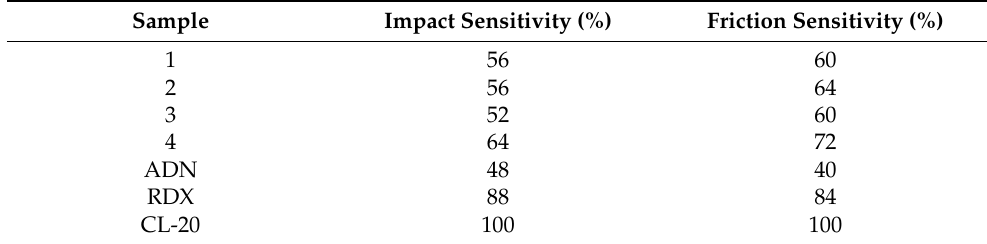
Table 3. The test results of mechanical